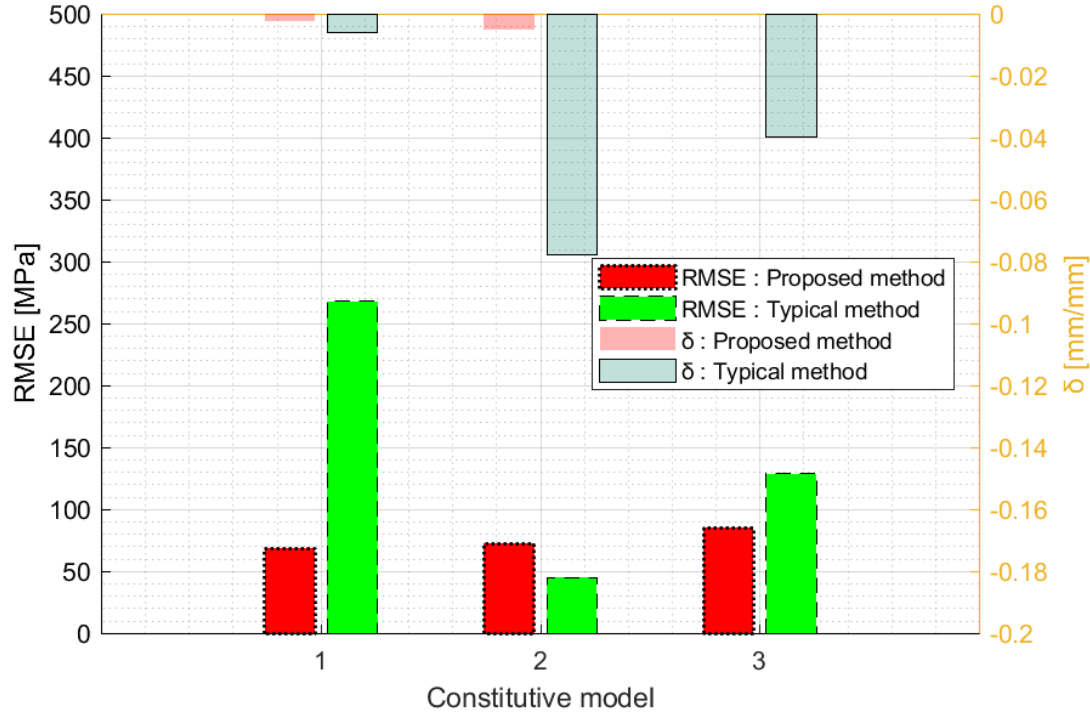
Figure 9. Comparison between RMSE values of FE simulation results and test results.